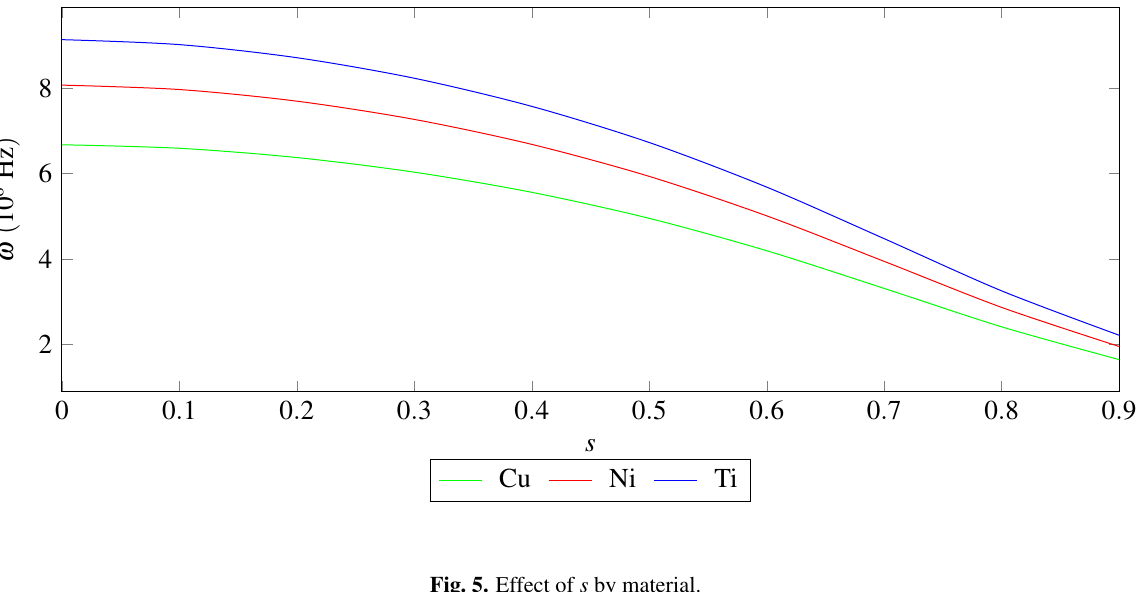
Fig. 5. Effect of s by material.